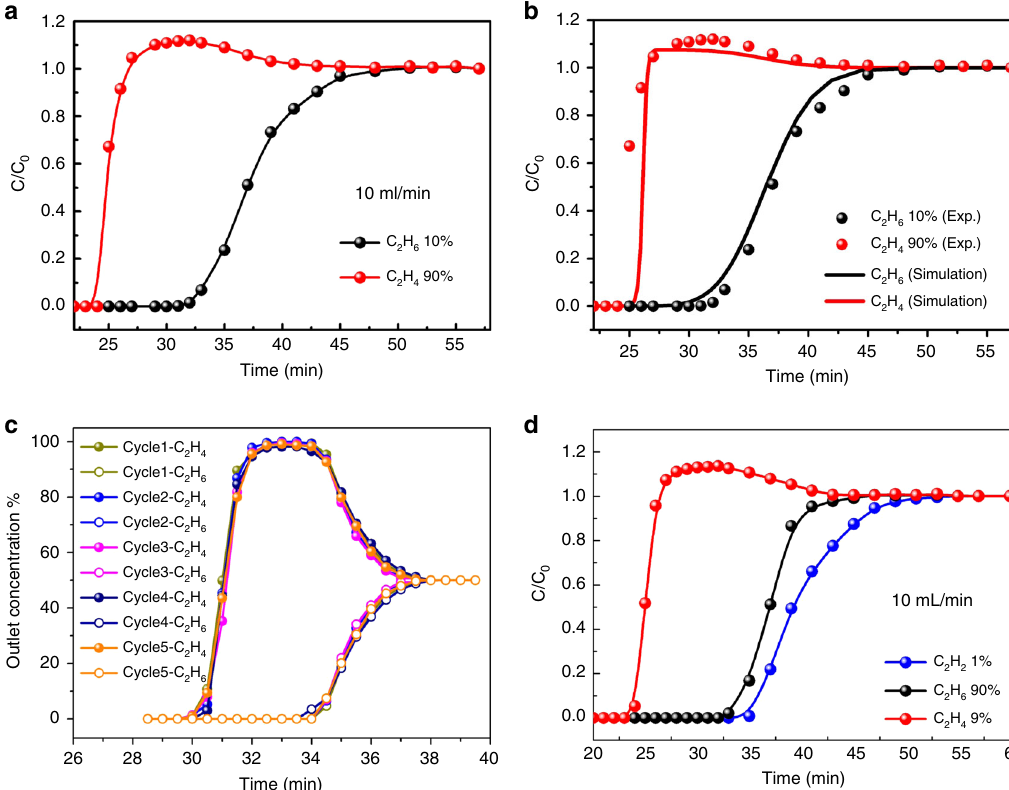
Fig. 5 Experimental breakthrough curves at 298 K and 1 bar on Azole-Th-1. a , b C 2 H 6 /C 2 H 4 (10/90, v/v) binary mixture. c C 2 H 6 /C 2 H 4 (50/50, v/v) binary mixture for fi ve cycles. d C 2 H 6 /C 2 H 4 /C 2 H 2 (90/9/1, v/v/v) ternary mixture separation. Source data are provided as a Source Data fi